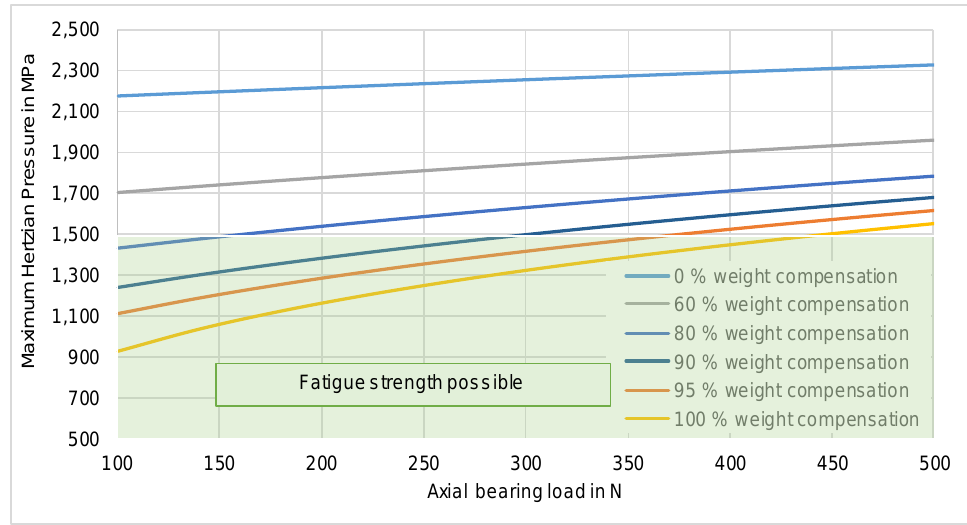
Figure 17. Maximum Hertzian Pressure as a function of axial bearing load for different degrees of weight compensation for a system with two myonic – SRD 30550VA bearings mounted in a resilient bearing suspension–Simulation conducted with MESYS Shaft (Version 07-2019, MESYS AG,